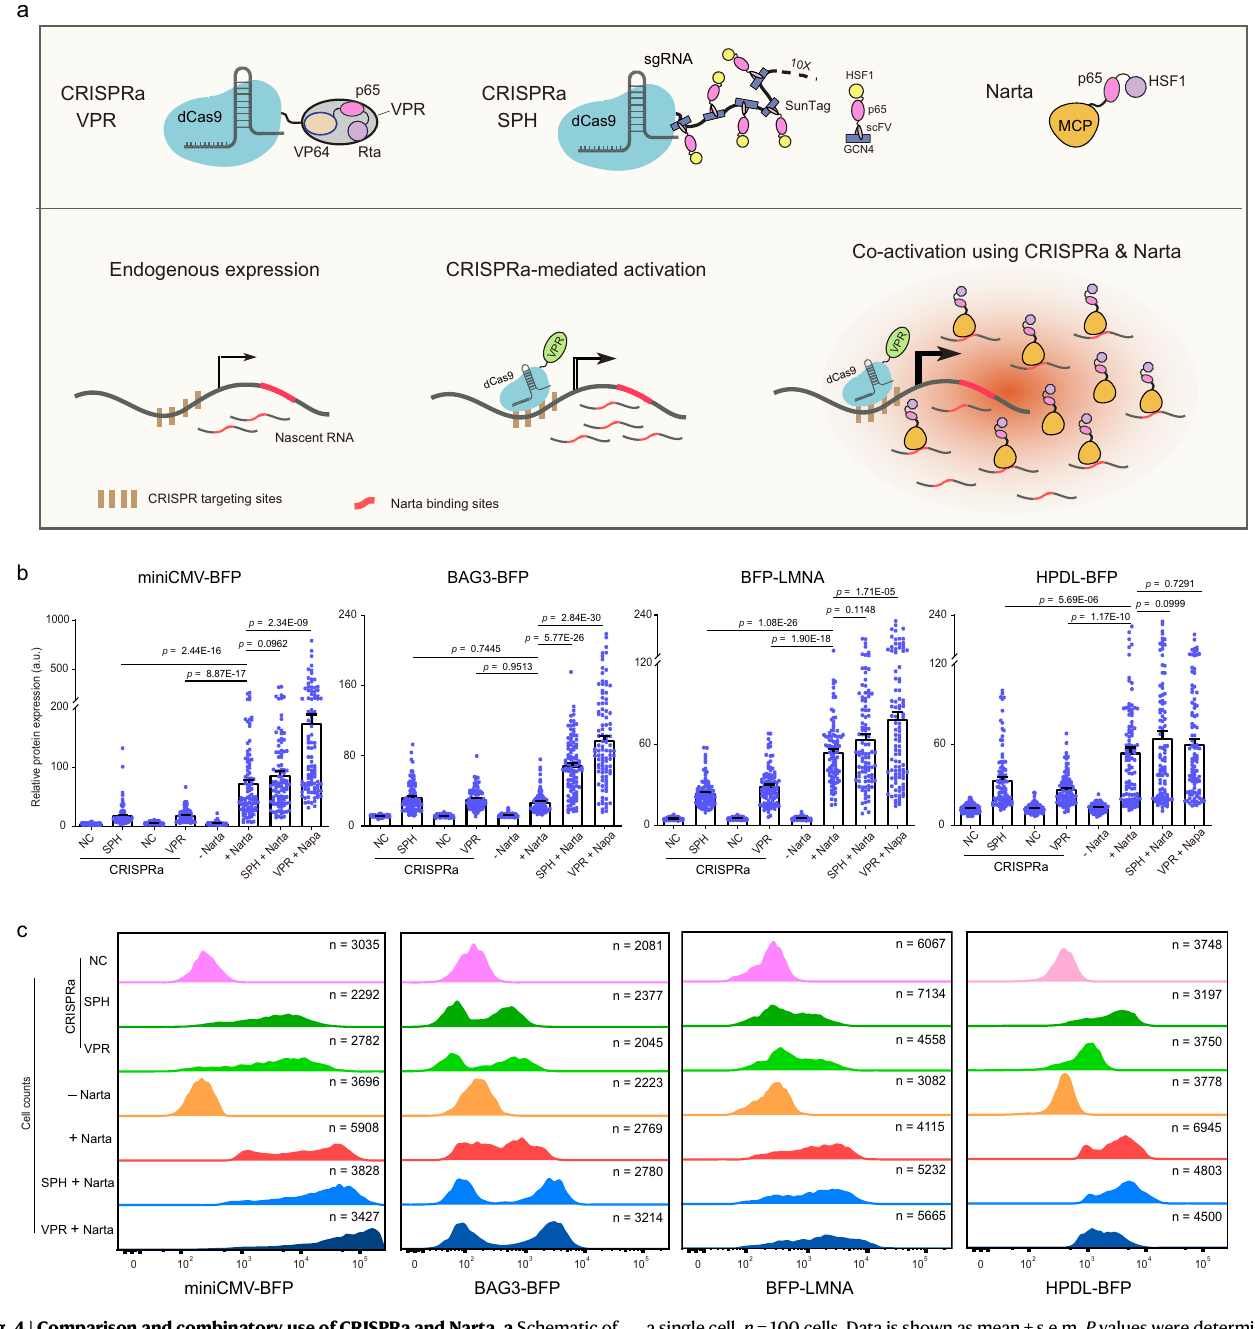
asinglecell. n =100cells.Data isshown as mean±s.e.m. P valuesweredetermined by One-way ANOVA with Tukey ’ s post hoc. c Flow cytometry quanti fi cation of target protein expression levels under the same conditions as in b . Transfection- positive cells were gated based on internal reporters (GFP or HaloTag). The dis- tributionofthesecellswasplottedbasedonthe fl uorescenceintensityofBFPfused to the target gene ( y axis ). x axis is the number of cell counts. Source data are provided as a Source Data fi